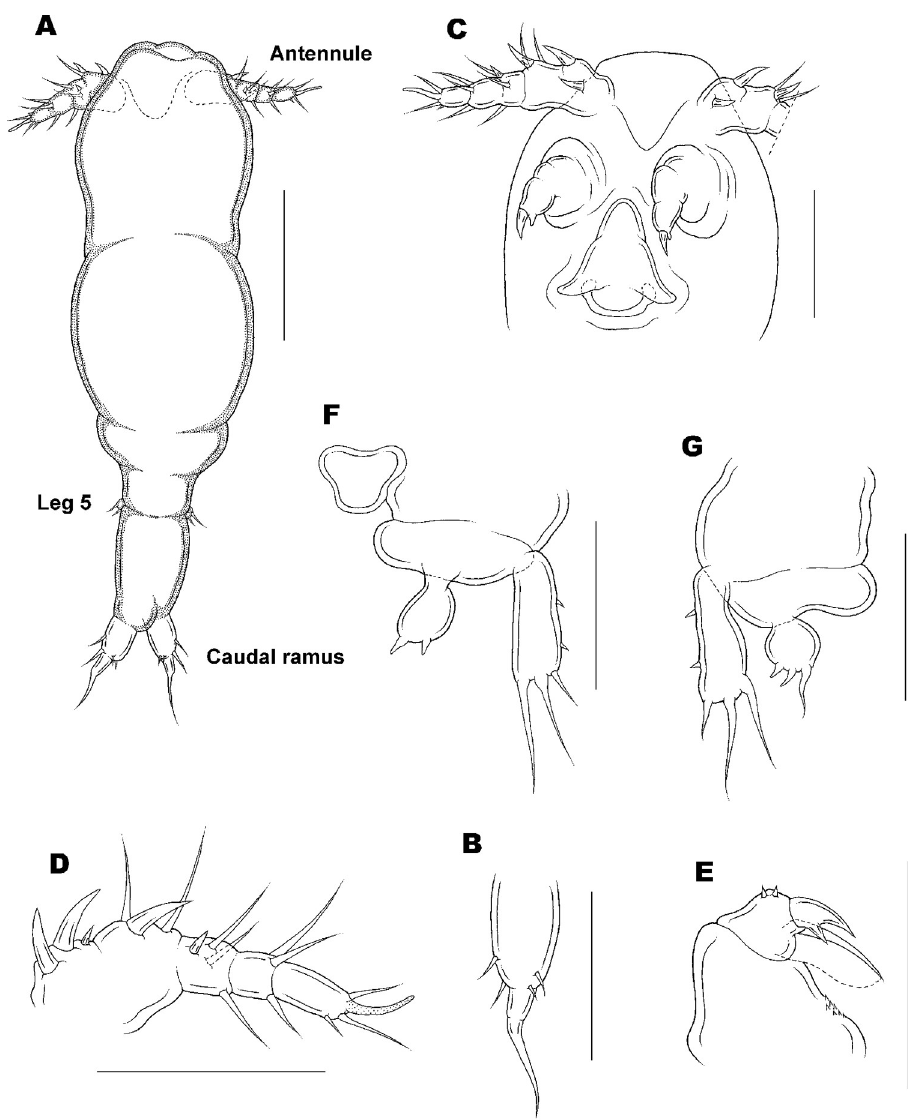
Fig 8. Copepodid stage III of Ive ptychoderae . (A) Habitus, dorsal; (B) Caudal ramus; (C) Antennal area and oral region, ventral; (D) Antennule; (E) Antenna; (F) Leg 1; (G) Leg 2. Scale bars: A = 0.05 mm; B–G = 0.025 mm.